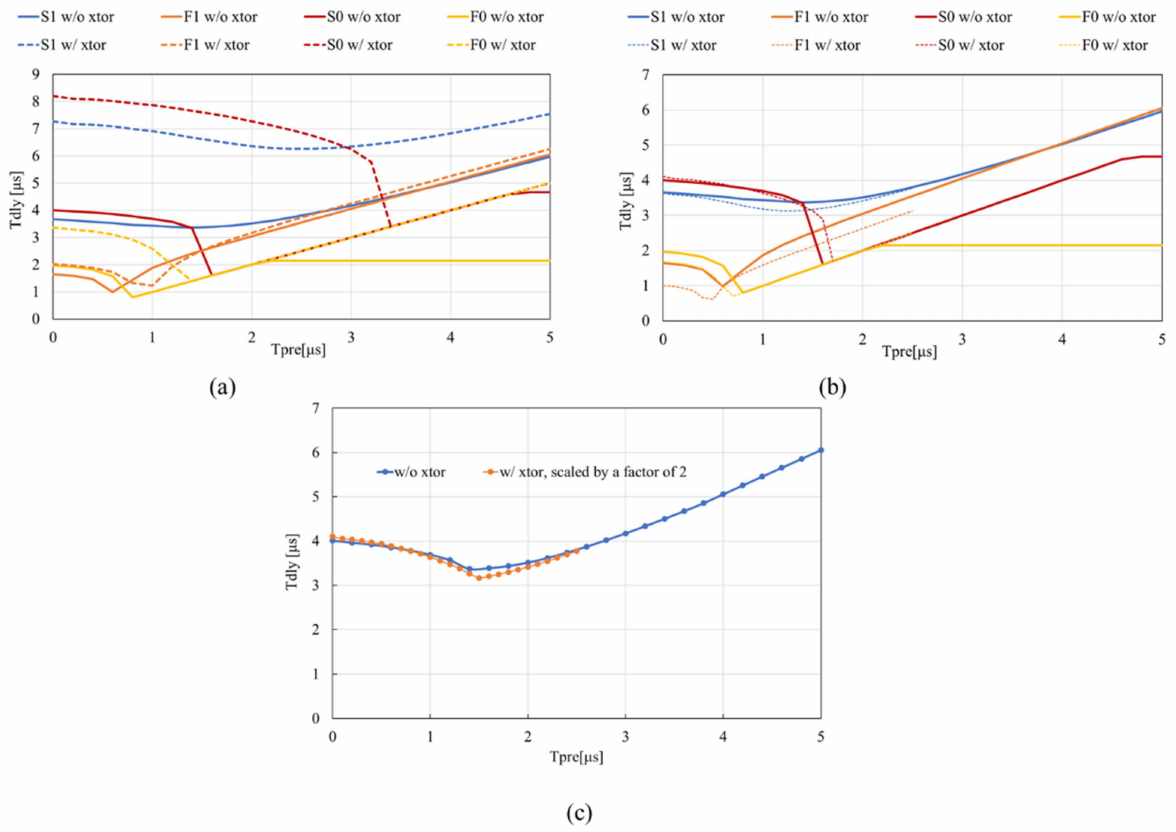
Figure 13. Sensed current delay as a function of Tpre for the netlist with and without PASS transistors with raw data ( a ) and with scaled data for “with transistors” ( b ). The worst case Tdly is compared in ( c